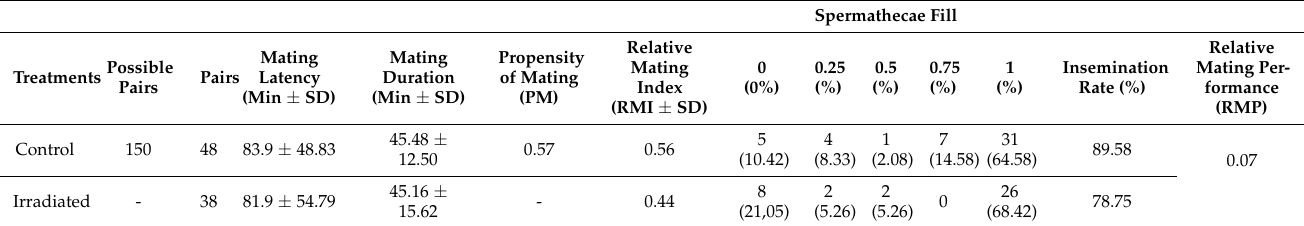
Table 4. Summary mating parameters of Glossina palpalis gambiensis irradiated and non-irradiated males mated with virgin